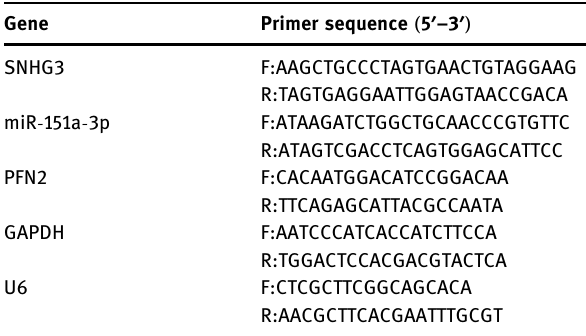
Table 1: The primer sequences used for RT - qPCR